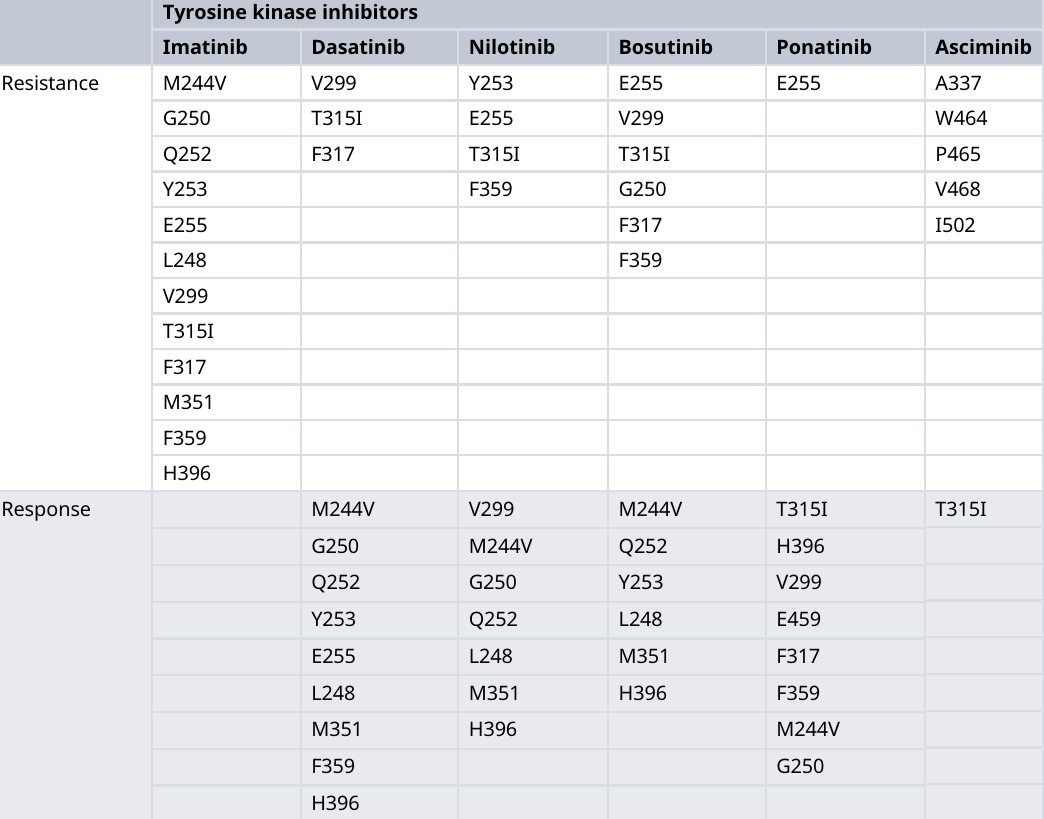
Table 1. The types of kinase domain mutations with their response and resistance to imatinib, dasatinib, nilotinib, bosutinib, ponatinib, and